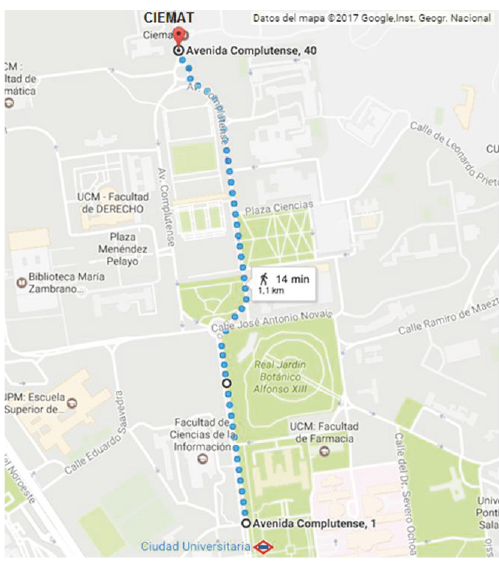
Figure 4: Moncloa Campus, Ciudad Universitaria underground station, and CIEMAT